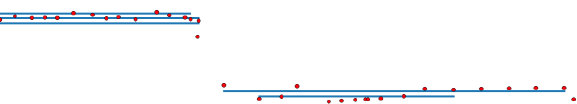
Figure 2. Detailed view of alpha shape boundary points (red) and detected line segments by adapted Hough transform